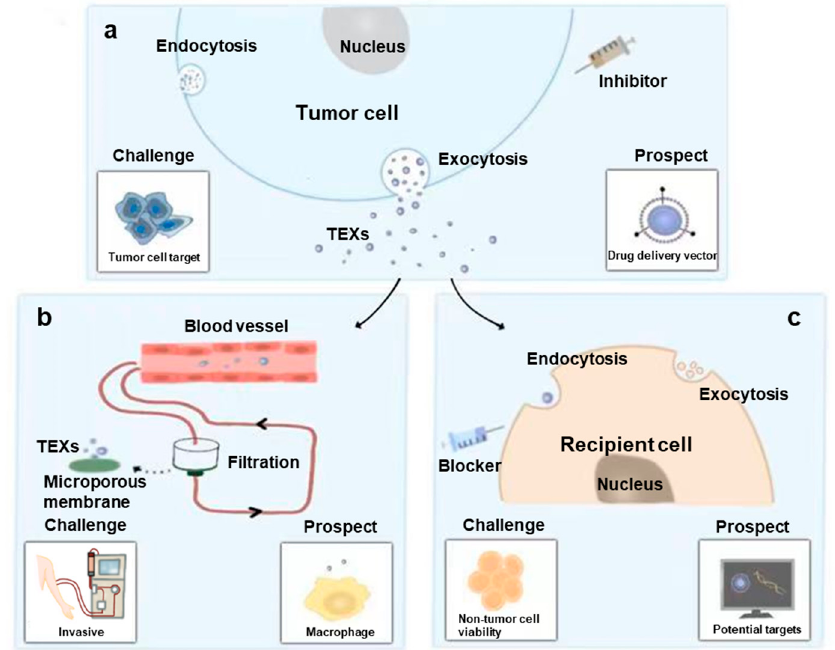
Figure 4. Challenges and prospects for TEX-targeted therapies. TEX-targeted therapies can be divided in three ways: inhibit biogenesis, tracking and secretion of TEXs ( a ), facilitate TEXs clearance ( b ) and block function of TEXs ( c ). For TEX inhibiting therapy, tumor-targeted drug delivery vectors will be a promising option to promote the tumor-targeted ability of exosomal inhibitor. For TEXs clearance therapy, side effects are inevitable due to invasive procedure. The novel strategy should